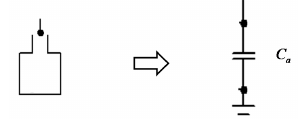
Figure 2. Equivalent circuit of electromagnetic domain.